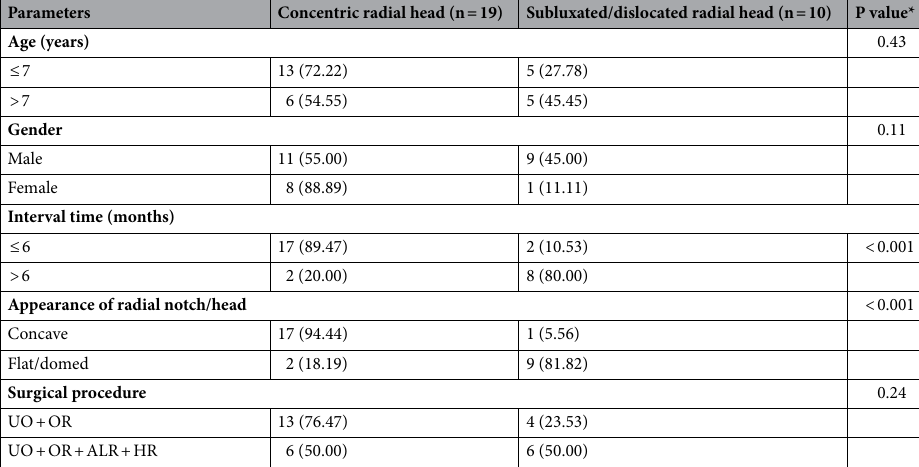
Table 4. Univariate analysis of factors that might affect the postoperative radiographic results. *Fisher’s exact test; P ≤ 0.05, statistically significant.